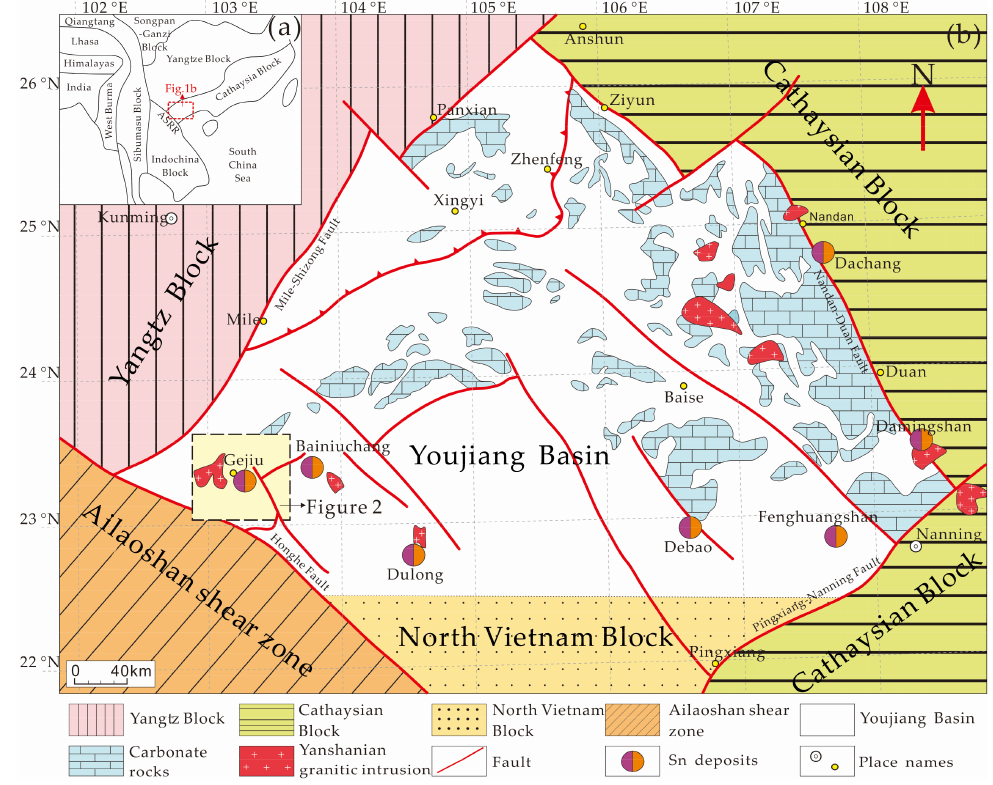
Figure 1. ( a ) Simplified geological map of eastern Asia, showing the major tectonic units [25,31], ASRR = Ailao Shan–Red River shear zone. ( b ) Geological map showing the distribution of tin deposits, including Gejiu in the Youjiang Basin, SW China (modified from